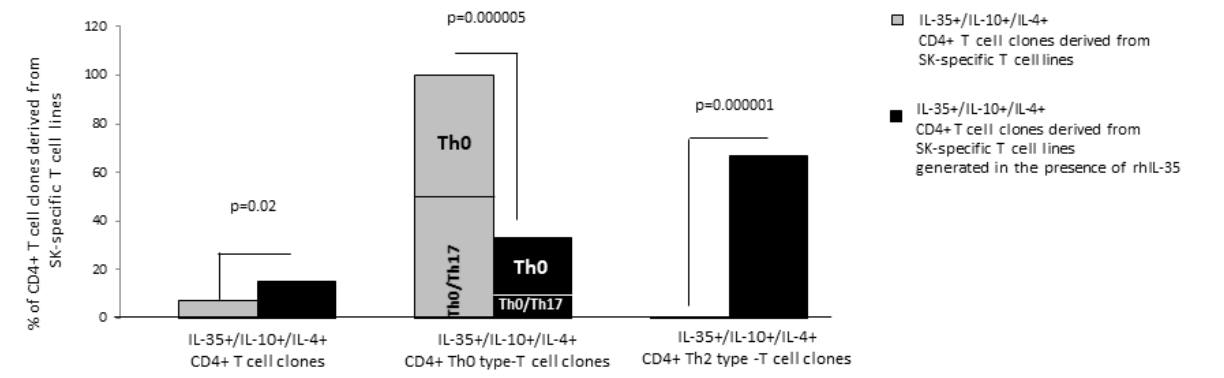
Figure 2. rhIL-35 favors the development of IL-35 + IL-10 + IL4 + Th2-type cells in SK-specific CD4+ T-cell lines. T-cell blasts from SK-specific T-cell lines generated in the absence or in the presence of rhIL-35 (300 pg/mL) derived from the peripheral blood of two different donors were cloned under limiting dilution conditions. The SK-specific T-cell clones derived from the SK-specific T-cell lines generated with rhIL-35 and without rhIL-35 were assessed for their cytokine profiles in response to stimulation with PMA plus anti-CD3 mAb. The percentage of CD4+ T-cell clones, Th2-type T-cell clones, and Th0-type T-cell clones producing IL-35, IL-10, and IL-4 was determined. These results indicate that the Th2-type CD4+ T-cell clones producing IL-35,